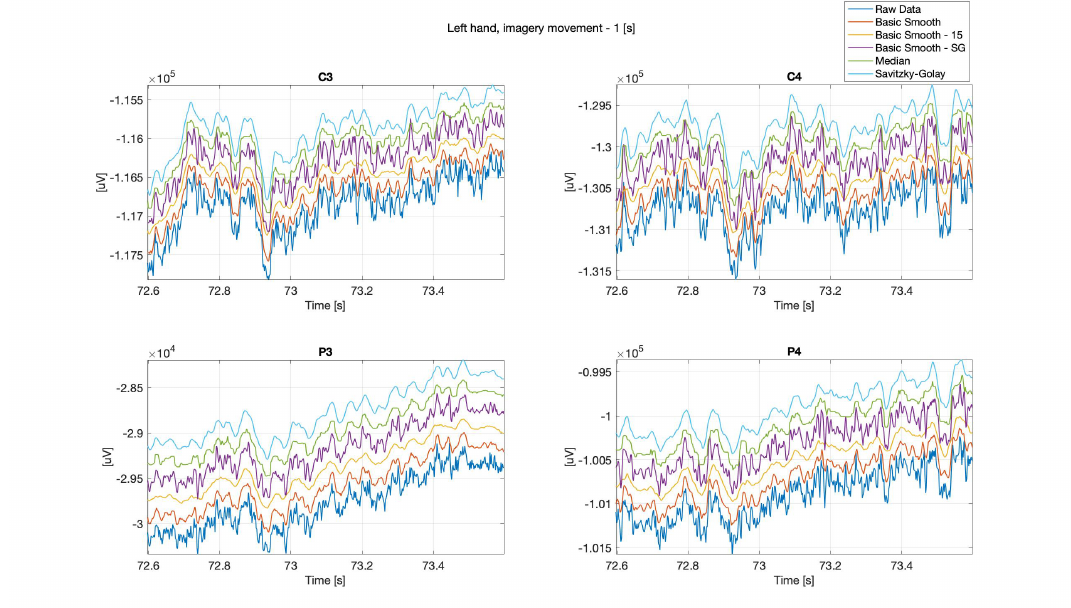
Figure 9. Left hand, imagery movement, C3, C4, P3 and P4 channels.